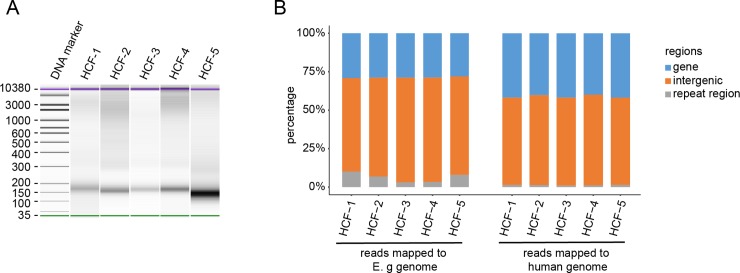
Profiles of cfDNA extracted from intact hydatid cysts.(A) Size of cfDNA from HCF samples analyzed on a 2100 bioanalyzer. Molecular weight (bp) is indicated (left lane). Green lines:15bp. Purple lines: 1500bp. (B) Profile of the cfDNA sequencing reads mapped to the E. granulosus genome (ASM52419v1) and human genome (hg38).